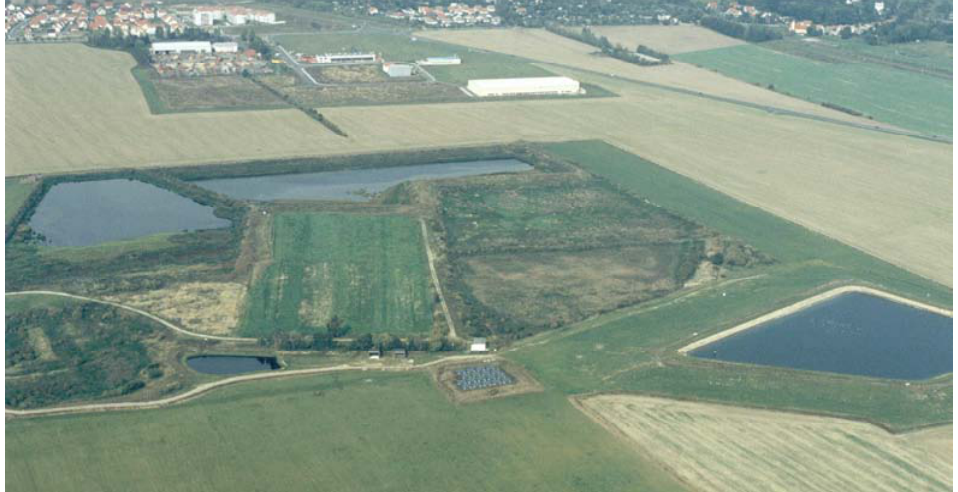
Fig 1. The site – Phytoremediation of a former sewage sludge deposit, Germany